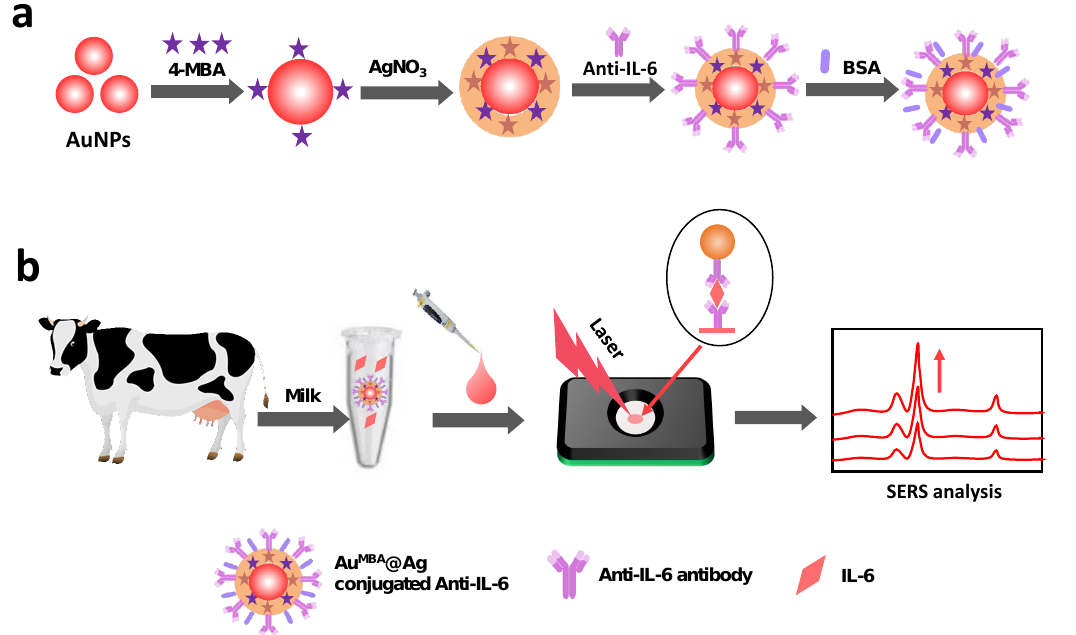
Figure 1. Schematic illustration of ( a ) the synthesis of bio-functionalized core-shell SERS nanotag; ( b ) the detection of IL-6 by core-shell SERS nanotags combined with the IFA